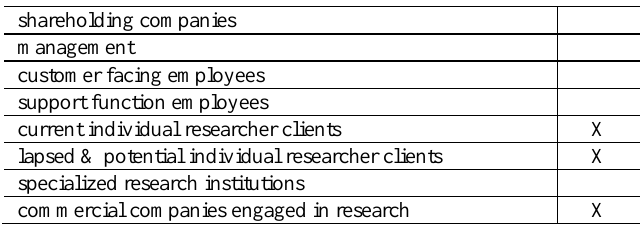
Table 6: Participants loading on Factor 3